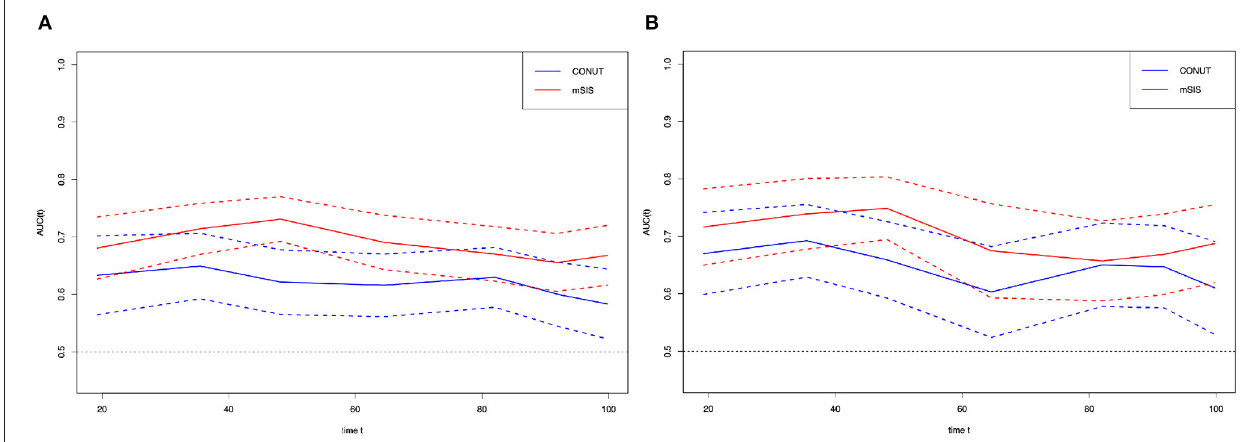
FIGURE 3 | Time-dependent ROC curves for the mSIS and CONUT. The horizontal axis represents the year after surgery, and the vertical axis represents the estimated AUC for survival at the time of interest. Red and blue solid lines represent the estimated AUCs for the mSIS and CONUT, respectively, and broken lines represent the 95% confidence intervals for each AUC. (A) overall survival. (B) relapse-free survival. CONUT, controlling nutritional status. mSIS, modified systemic inflammation score; AUC, area under the curve; ROC, receiver operating